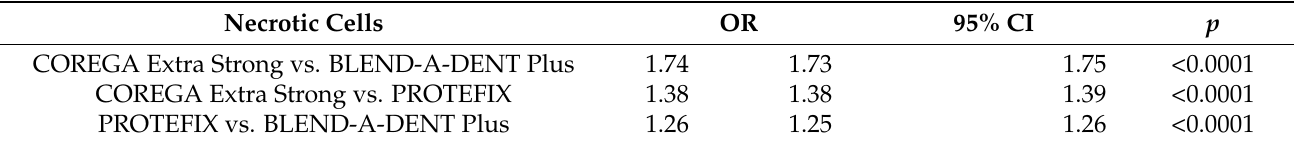
Table 5. Risk of detecting of necrotic cells for different adhesives.